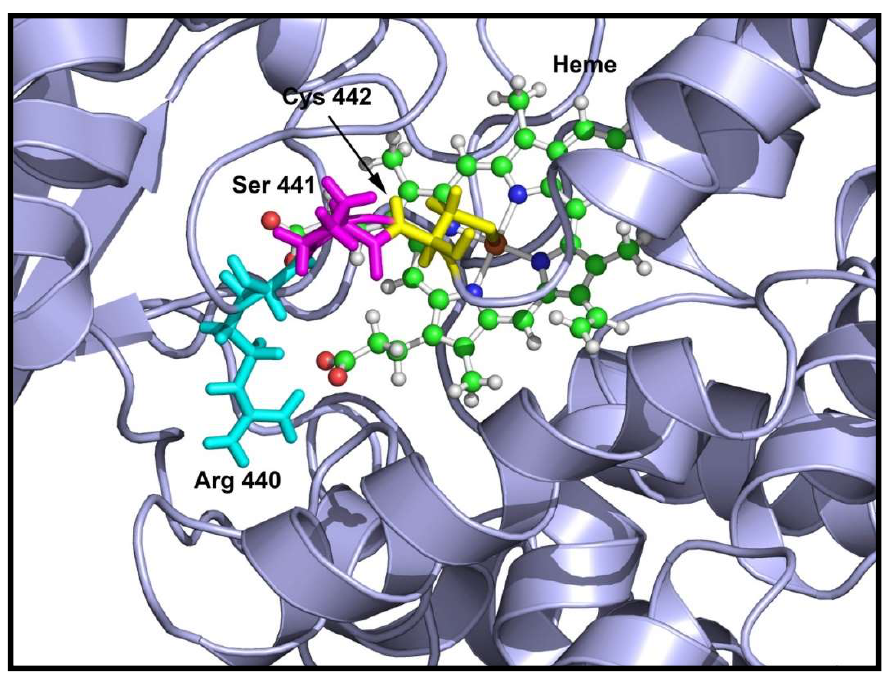
Figure 5. Location of S441P mutation in CYP17A1 structure showing the affected amino acids. The cysteine 442 is shown in yellow, serine 441 is in magenta and arginine 440 is in cyan. Both the cysteine 442 and arginine 440 are required for heme binding and the serine 441 to proline mutation creates a bend in the loop containing the cysteine 442 and arginine 440 residues, resulting in loss of heme binding that leads to an inactive enzyme.